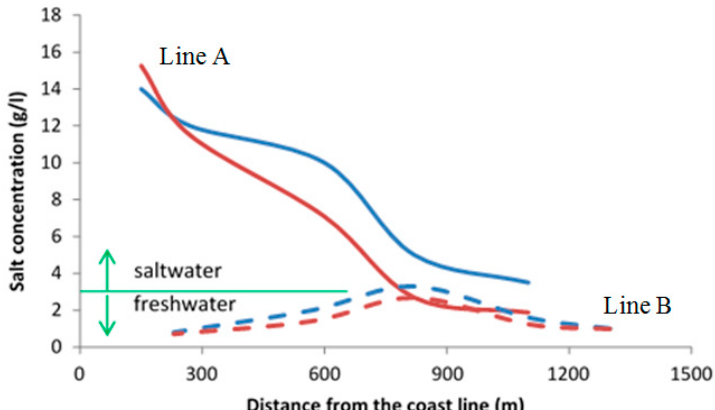
Figure 8. Comparison between salinity trends estimated by using ERT (red lines) and by using the Ghyben Herzberg model (blue lines). Solid lines represent the Line A groundwater section; dotted lines represent the Line B groundwater section.